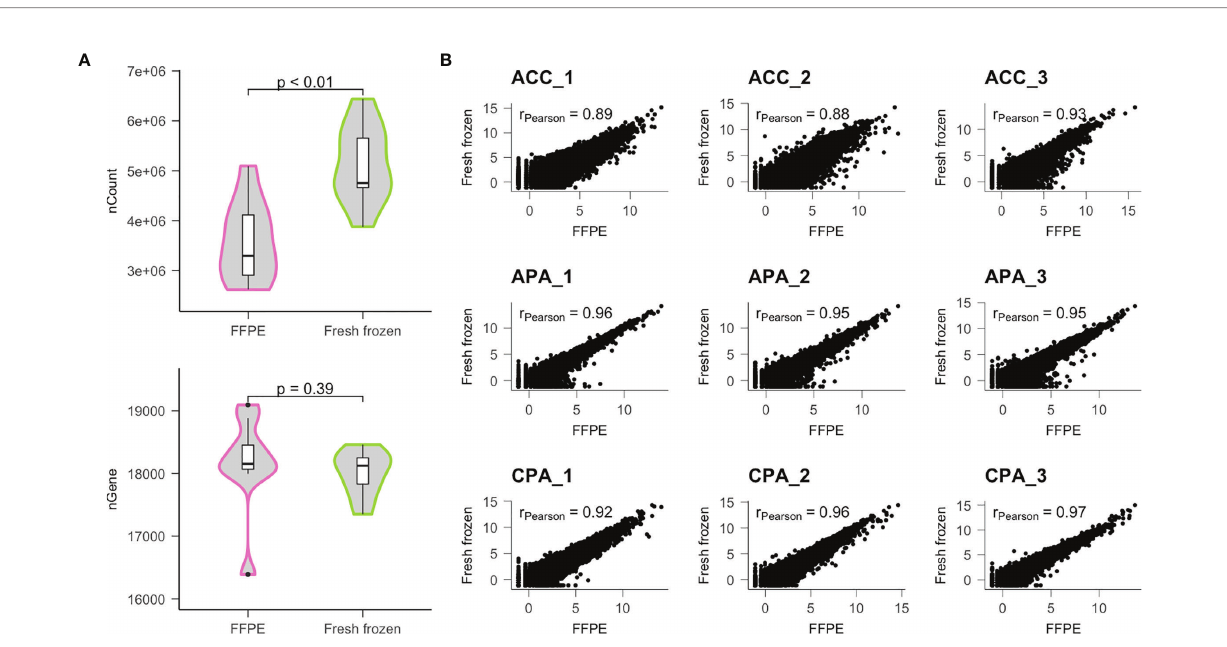
FIGURE 1 | Comparison of transcriptome data obtained from FFPE and fresh frozen samples. (A) Distributions of the number of read counts (nCount) and the number of genes detected (nGene) were compared between FFPE and fresh frozen samples. (B) Results of correlation analysis between FFPE and fresh frozen samples for each patient. r; Pearson ’ s correlation coef fi